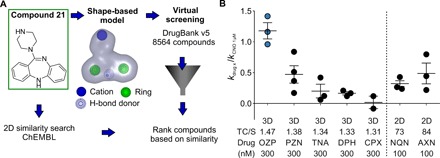
Shape- and 2D similarity–based identification of hM4D(Gi) agonists.(A) Overview of the 3D- and 2D-based virtual screen. C21 was used as the query compound for both the 2D similarity search of the ChEMBL database and the generation of a 3D shape–based model, because it showed the lowest EC50 at hM4D(Gi) of known agonists. For detailed virtual screening results, see table S1. (B) hM4D(Gi)-dependent potentiation of Kir3.1/Kir3.2-mediated currents measured for selected hit compounds is normalized by 1 μM CNO as positive control. The TanimotoCombo (TC) score (for 3D screen), similarity (S) index (for 2D screen), the screening method (3D or 2D; separated by dotted line), and the tested concentration are indicated. For detailed structures of selected drugs, see table S2.